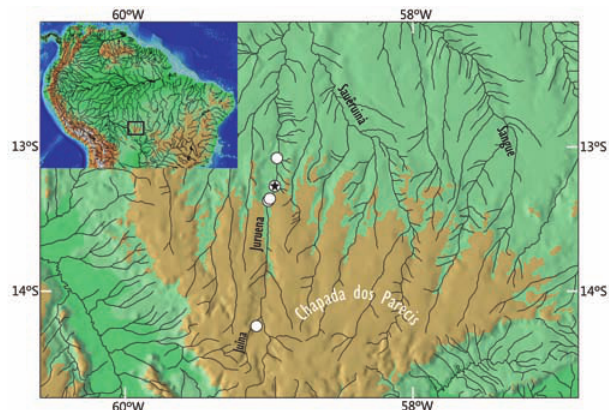
Fig. 5. Distribution of Moenkhausia rubra . Black star represents type locality. Symbols may represent more than one